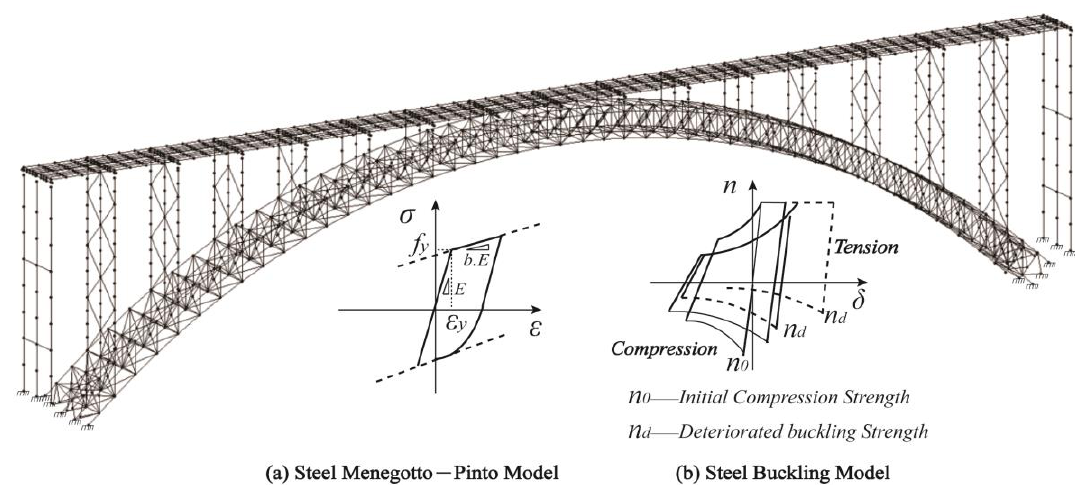
Figure 4. Finite element model of bridge.